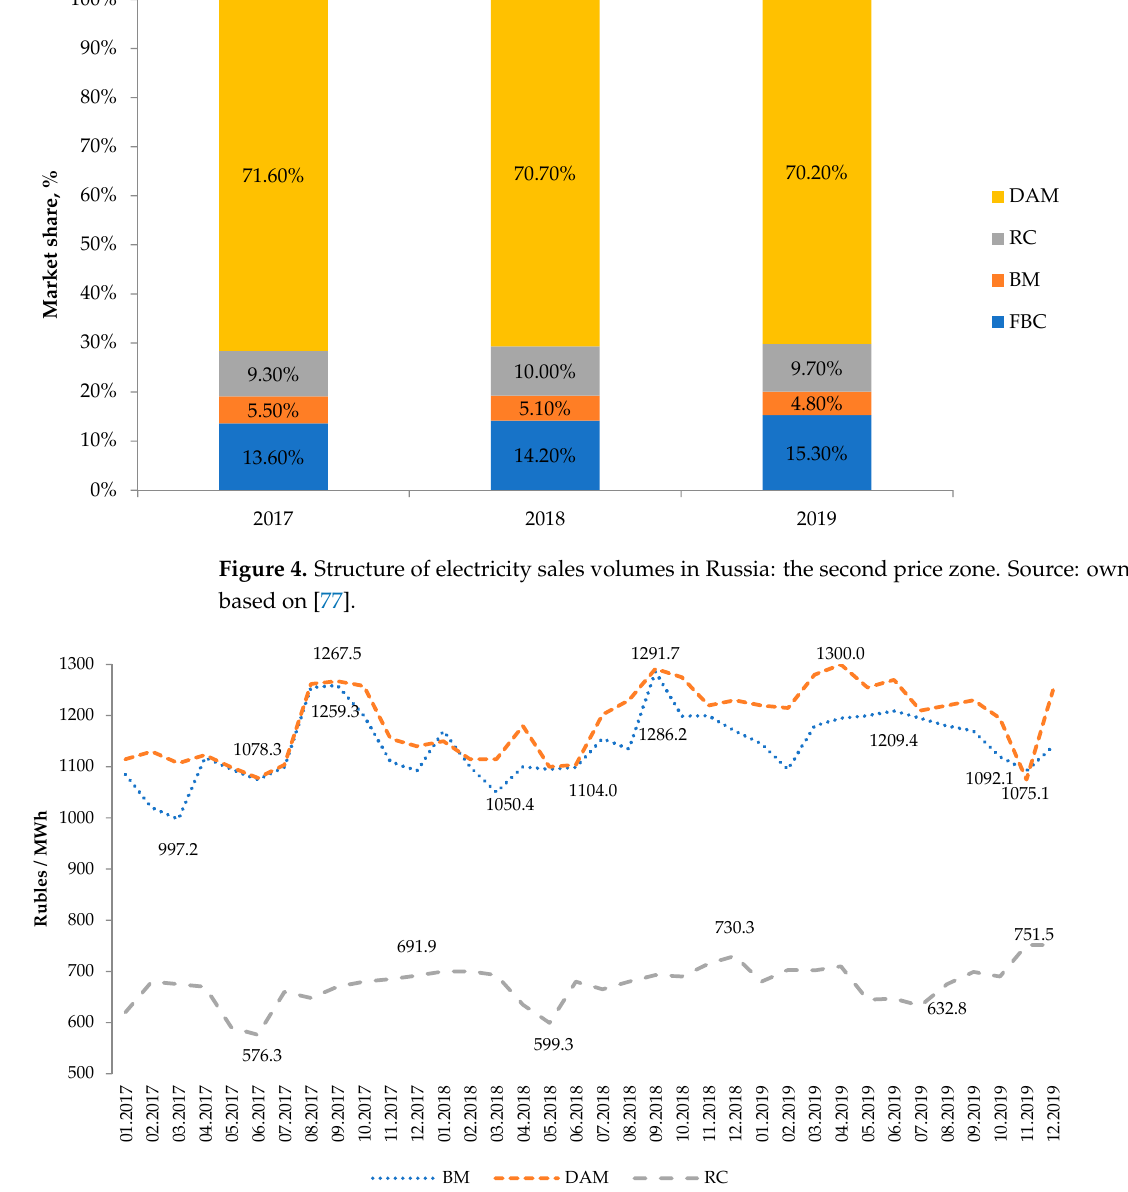
Figure 5. Weighted average electricity purchase price in the wholesale market: first price zone. Source: own results based on [78].